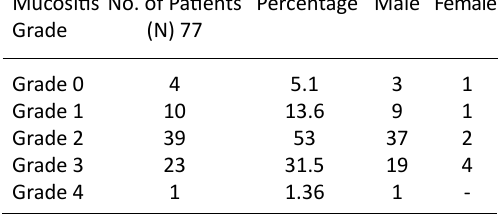
Table 4. Mucositis grade in